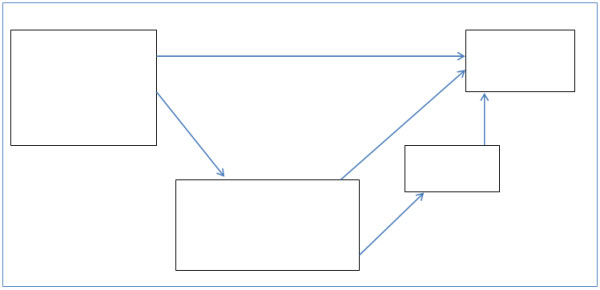
Theoretical model.